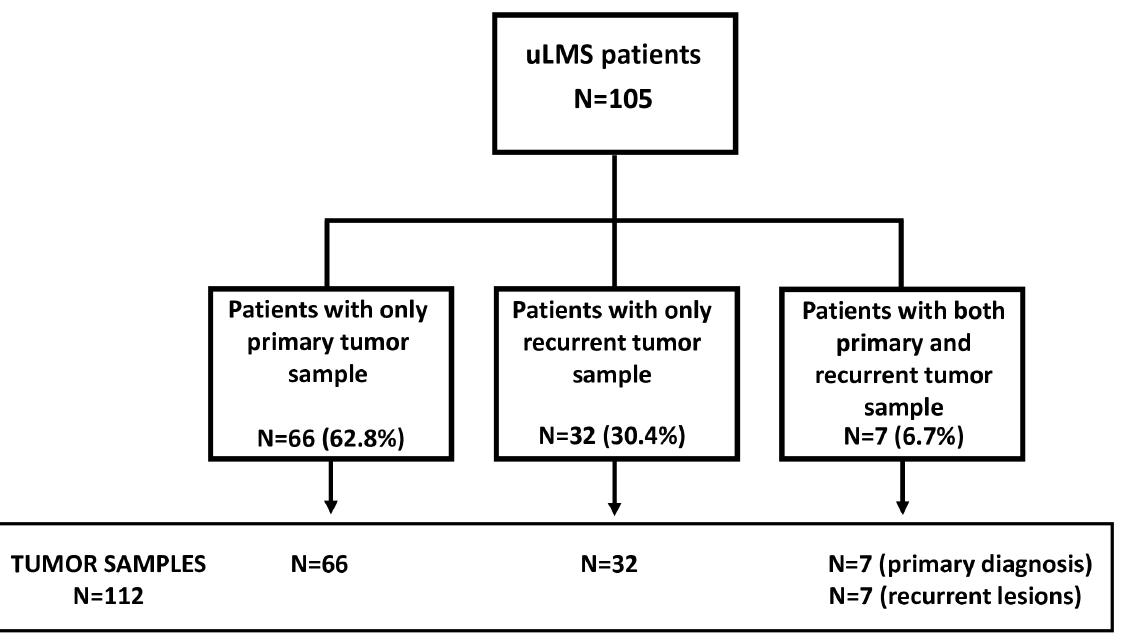
Figure 1. Flow chart of patients and tumor tissue samples. Table 1. Baseline characteristics of uLMS patients.